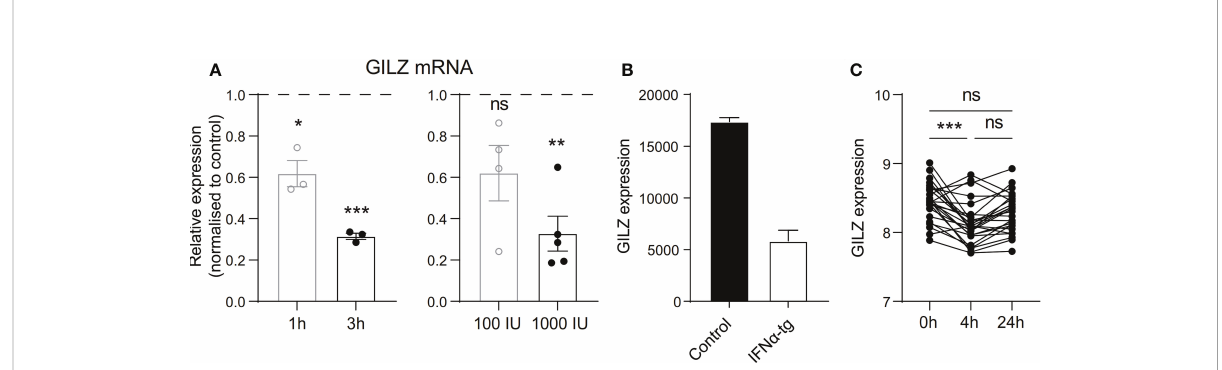
FIGURE 2 Type I IFN inhibits GILZ expression in human and mouse. (A) Healthy PBMC were treated with 1000 IU IFN a for 1 or 3 hours (left panel), or with 100 IU or 1000 IU for 3 hours (right panel), after which GILZ expression was analysed by qPCR. n=3-5, pooled from at least three independent experiments. (B) GILZ expression in splenocytes from WT or IFN a -overexpressing mice (GSE123549, n=2). (C) GILZ expression in PBMC from MS patients, before and 4 or 24 hours after injection of 500 µg IFN b (GSE138064, n=25-26). *p<0.05, **p<0.01, ***p<0.001. ns, Not signi fi